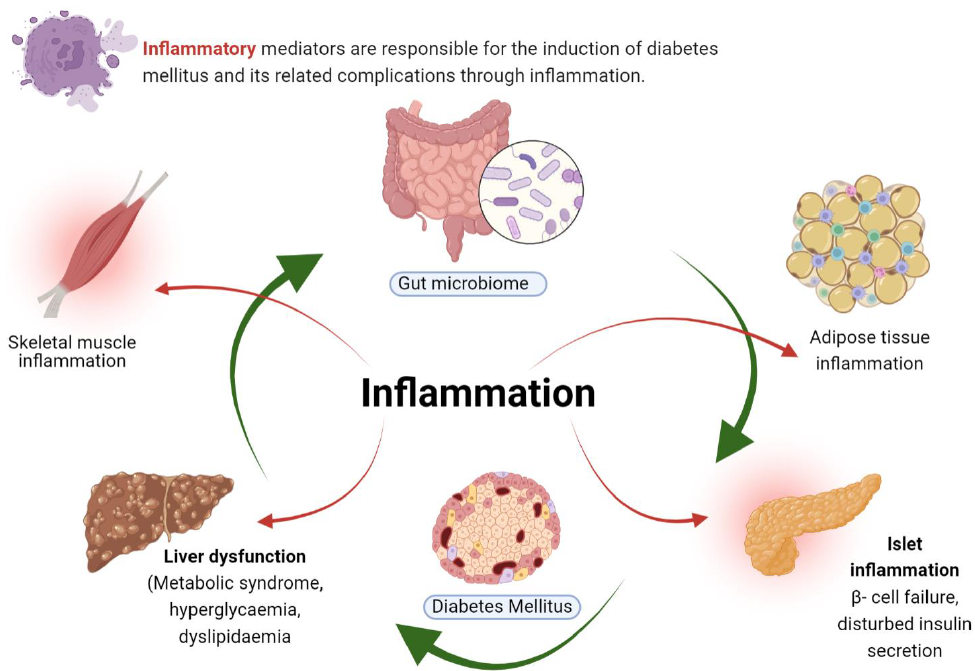
Figure 1. Diabetes mellitus and its inflammatory mediators. A variety of inflammatory cytokines are involved in the death of pancreatic β-cells that are activated via immune cells. In such immune disorder, the regulatory T-cells pose a defect while the effector T-cells target multiple β-cell auto-antigens and peptide epitopes that contribute to T1DM development. In addition, during the progression of T1DM, the immune β-cell profile also alters and macrophages become critical mediators of inflammation in islet cells because of reactive oxygen species generation in β-cells. This action on β-cells is considered to be a toxic one. Apart from this, dendritic cells and natural killer cells also contribute actively to this process .